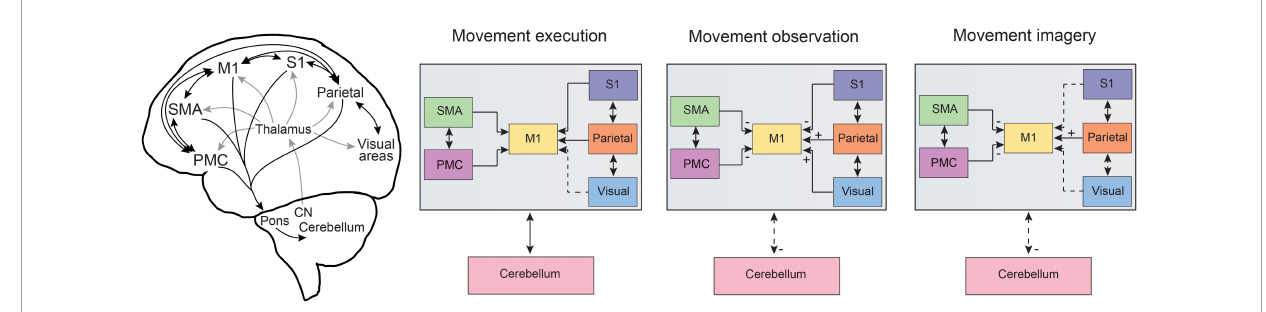
FIGURE2 Information flow across common distributed brain networks during movement execution, observation and imagery. Schematic representations of the distributed brain networks (left) show the gross anatomical cortico-cortical and corticocerebellar connections for brain regions related to motor processing. The general comparison of information flow for cortico-cortical as well as cortico-cerebellar pathways is summarized for movement execution, observation, and imagery. Dashed lines represent altered connectivity across conditions and ± symbols indicate changes in input across regions as based on a summary of neuroimaging studies and neurophysiological recordings in humans and monkeys as discussed in the text. Note that here we focus on pre-motor, motor, parietal, and sensory cortical networks as well as corticocerebellar pathways. An important role for lateral prefrontal cortex has been reviewed previously (see Rozzi and Fogassi, 2017) and the basal ganglia also plays an important role in cognitive-motor interactions (e.g., Yágüez et al., 1999; see also Leisman et al., 2014). CN, cerebellar nuclei; M1, primary motor cortex; PMC, pre-motor cortex; S1, primary somatosensory cortex; SMA, supplementary motor area, note SMA also includes preSMA; visual, refers to visual cortical pathways including striate and extrastriate regions, see text for